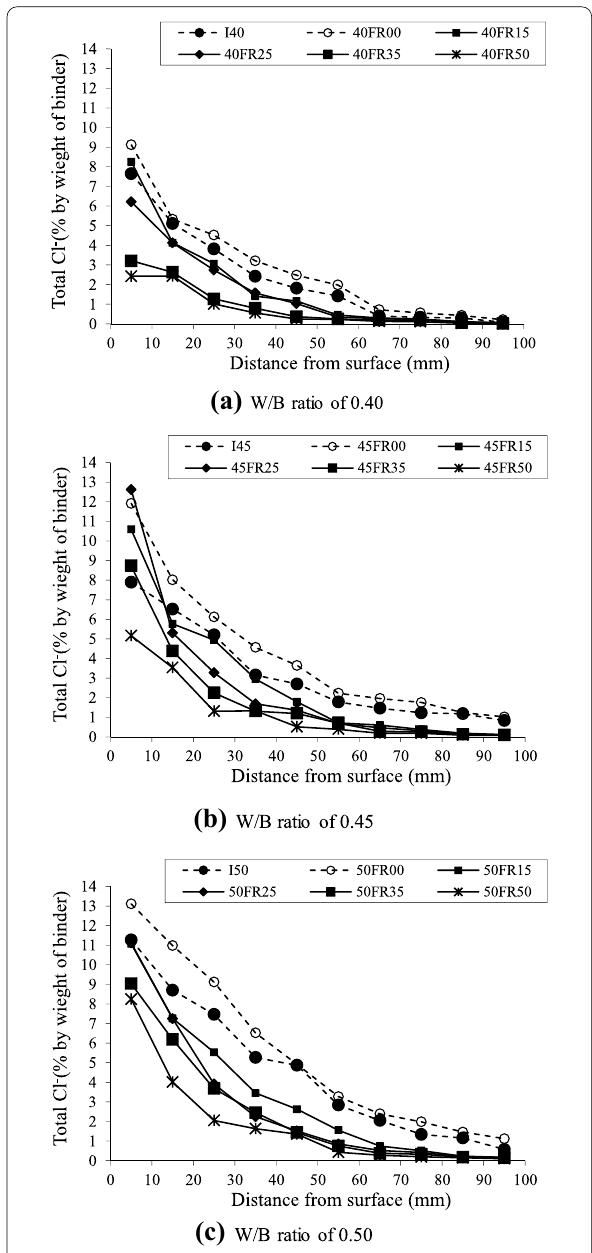
Fig. 3 Total chloride penetration profiles of NA and RCA concretes with a W/B ratio of a 0.40, b 0.45 and c 0.50 after 7-year exposure in a marine site.